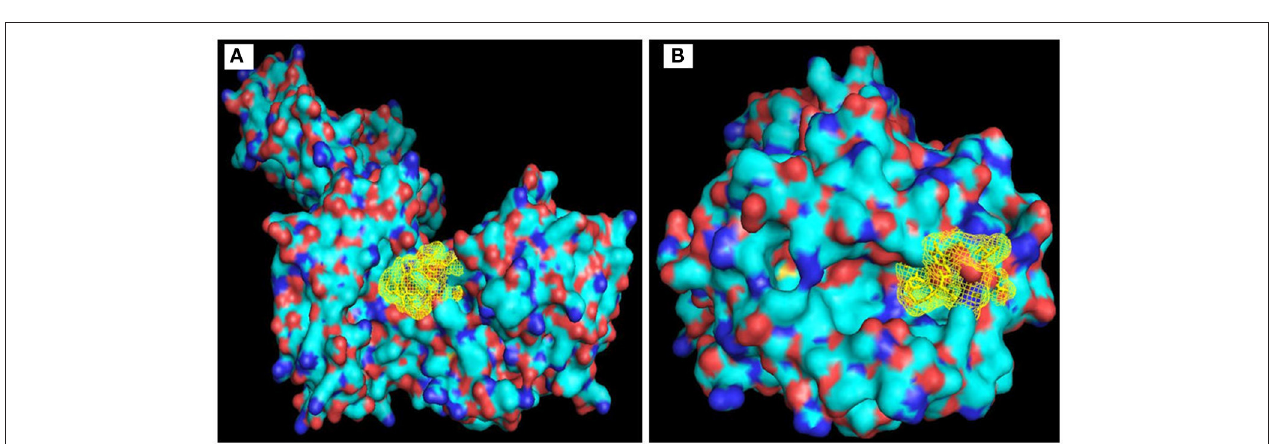
FIGURE 3 | Visualization of binding of KSLVHREW epitope with (A) MHC-I (HLA B*35:01); and (B) MHC-II (HLA-DR).